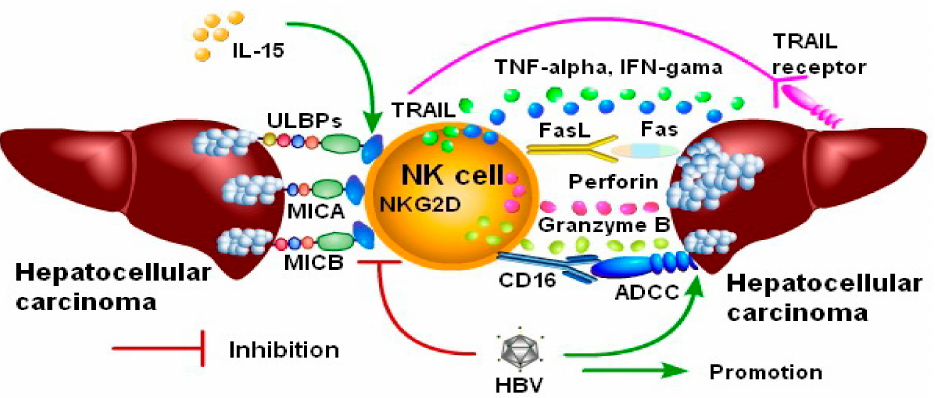
Figure 6. NKG2D on activated NK cells play crucial inhibitory e ff ects against hepatocellular carcinoma. The activated NK cells can express NKG2D, release multiple cytokines, secrete granzyme, express FasL, TRAIL, promote the target cells dissolve, and play e ff ective anti-hepatoma e ff ects in many ways. Both HBV particles and soluble ligand sMICA produced by hepatoma cells can e ff ectively inhibit NK cell